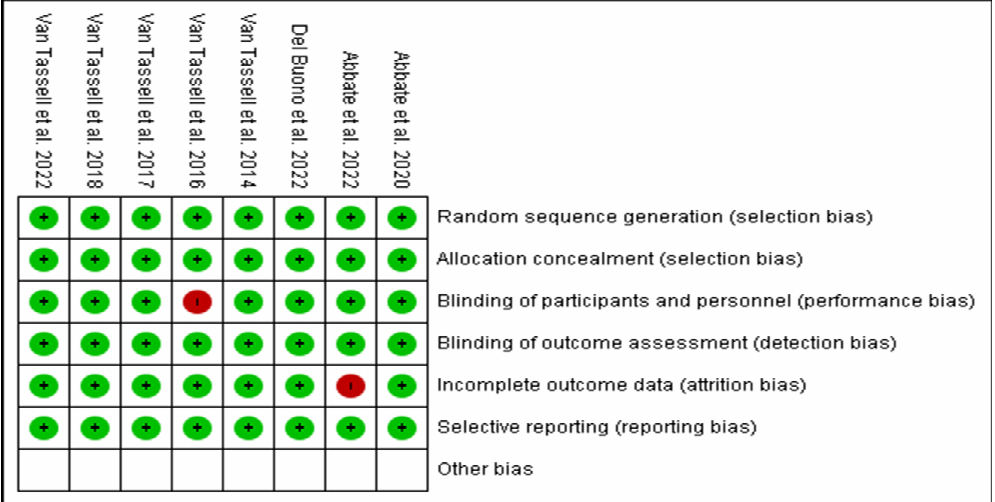
Figure 4. Risk of bias summary of the eight RCTs against various item evaluations [19,26–32].